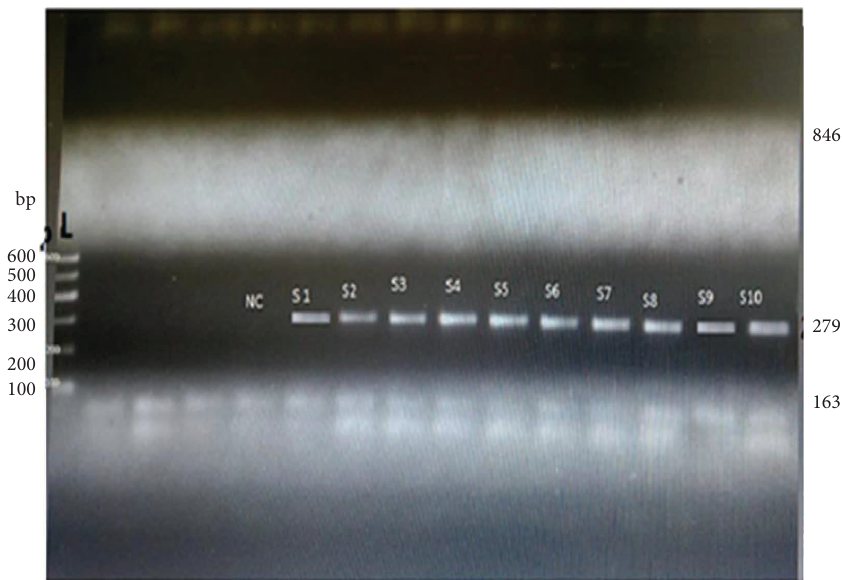
Figure 2: UV-illuminator imaged PCR product after electrophoresis in 1.5% agarose gel. L � ladder, S1–S10 denote samples, and NC stands for negative control. Description: the length of mecA � 163bp, nuc � 279bp, and blaZ � 846bp. Note: bp represents base